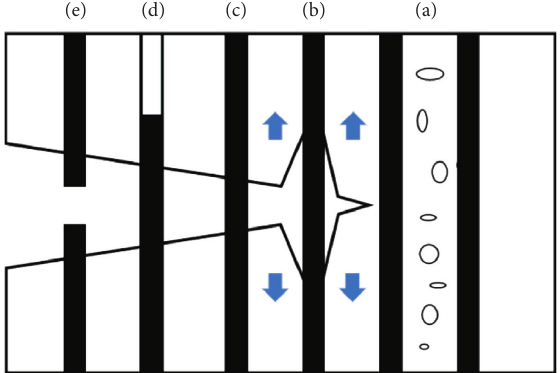
Figure 1: The roles of fiber embedded in cement matrix: (a) matrix cracking, (b) fiber/matrix debonding, (c) fiber bridging, (d) fiber pull-out, and (e) fiber